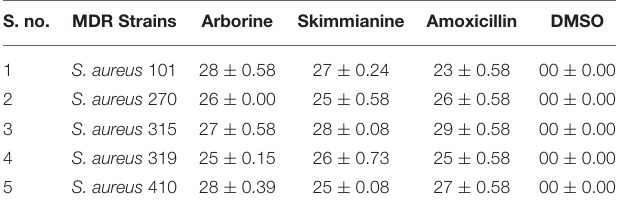
TABLE 5 | Anti-bacterial activity of arborine and skimmianine compounds against MDR S. aureus .